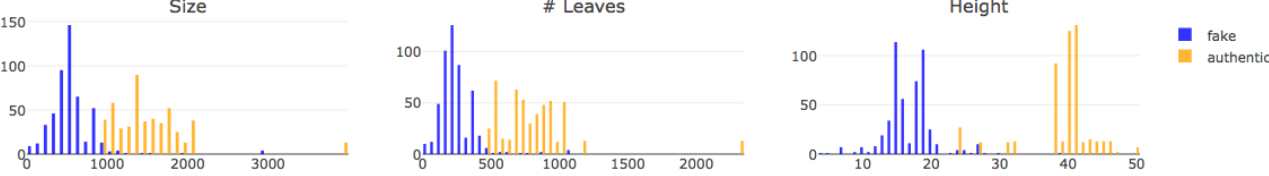
Figure 2. The size, the number of leaves and the height of DOM trees of fake and authentic sites.